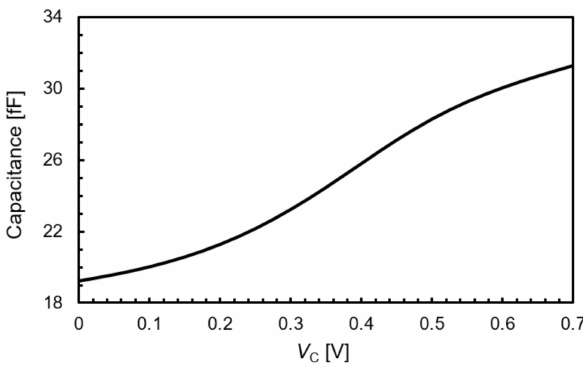
Figure 4. Simulated varactor response as a function of the control